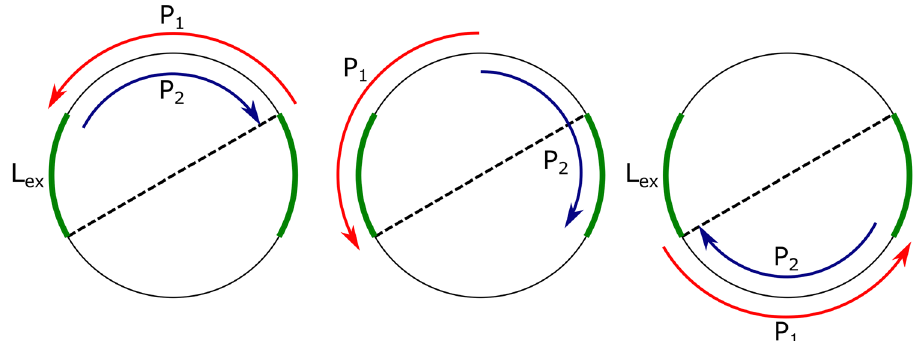
Fig. 6 Circulating pulse duration limits. This fi gure shows two counterpropagating pulses of maximal duration τ max circulating in a cavity with round trip path length L RT represented by the circumference of the circle. In the fi rst frame pulse-2 has just left the exclusive length ( L ex ) and pulse-1 is about to enter it. The condition for singular occupation of the exclusive length is clear from the fi rst and third frames L